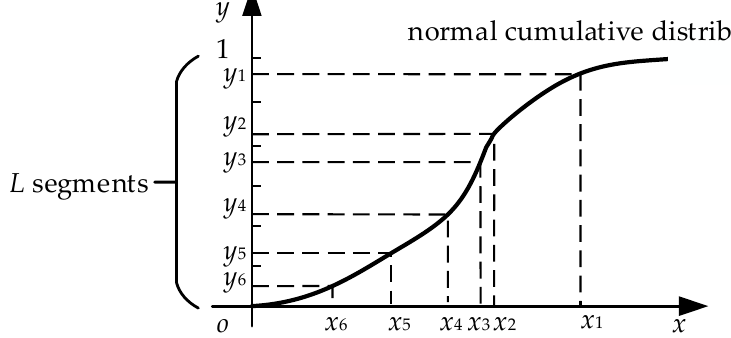
Figure 1. Principle of the LHS method (take L = 6 as an example).